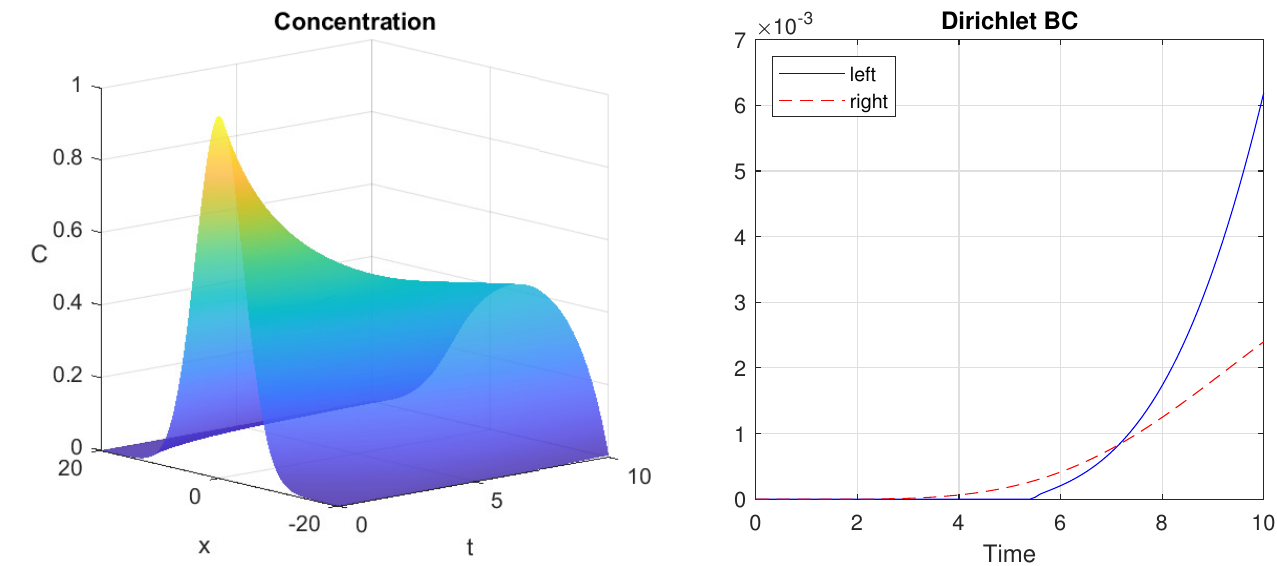
Figure 1. Concentration ( left ) and boundary conditions ( right ) for problems